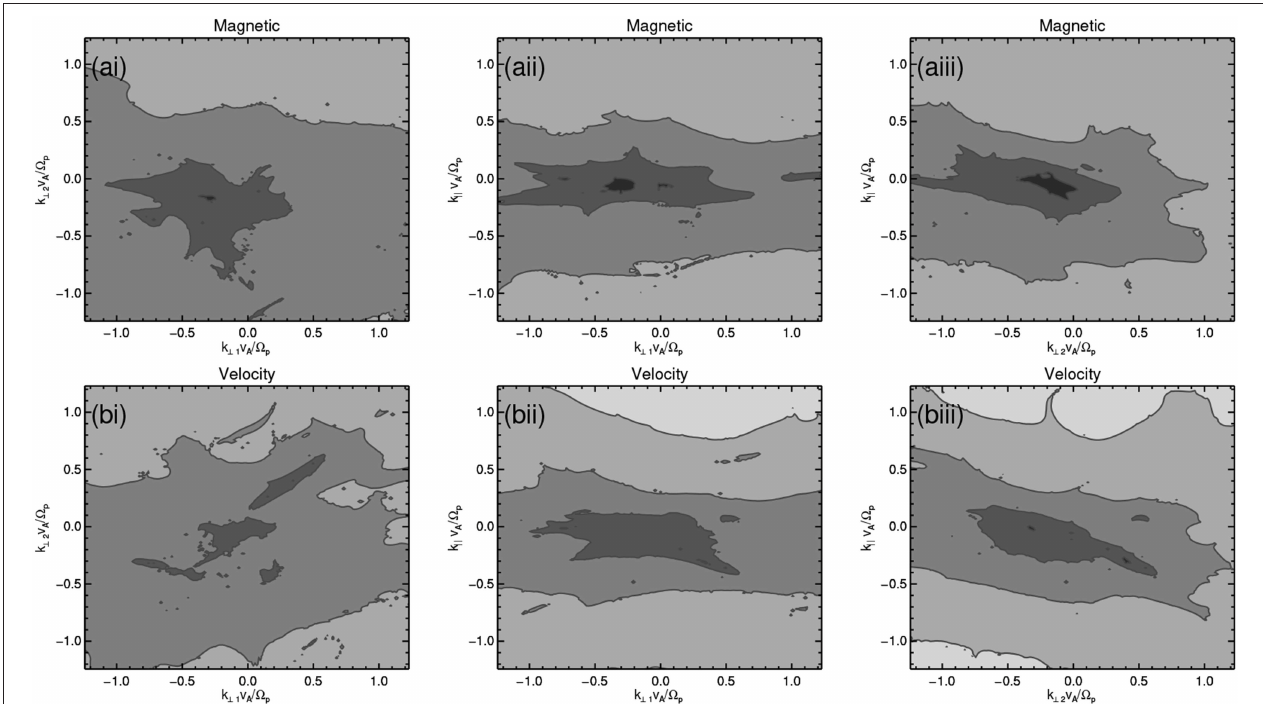
FIGURE 3 | Two dimensional representations of the three dimensional power distribution P ( k ) integrated over the remaining direction, for the magnetic field fluctuations (A) , the velocity fluctuations (B)